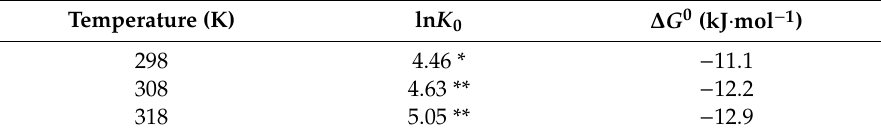
* Significant at 0.05 probability level. ** Significant at 0.01